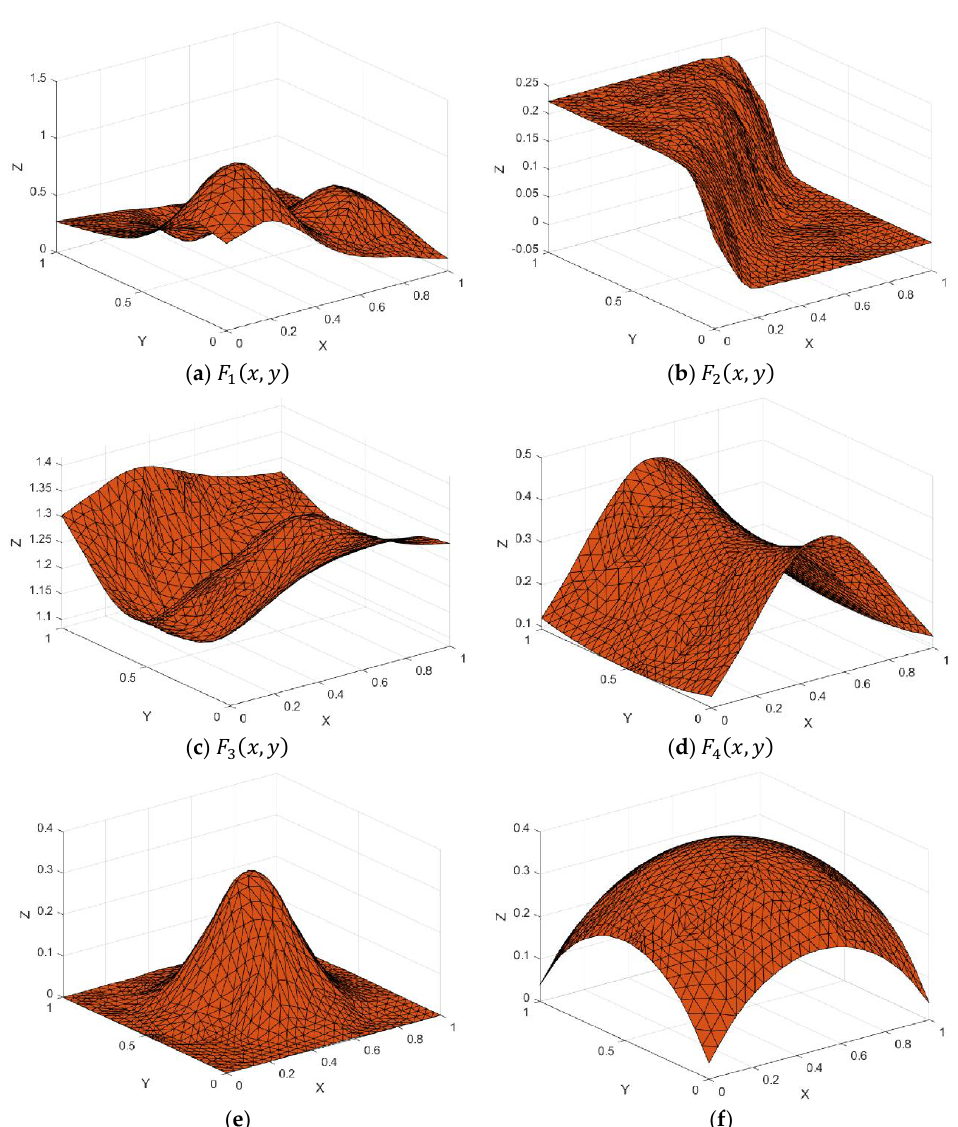
Figure 22. Surface interpolation using Foley and Opitz method and Choice 1 for 100 datasets.